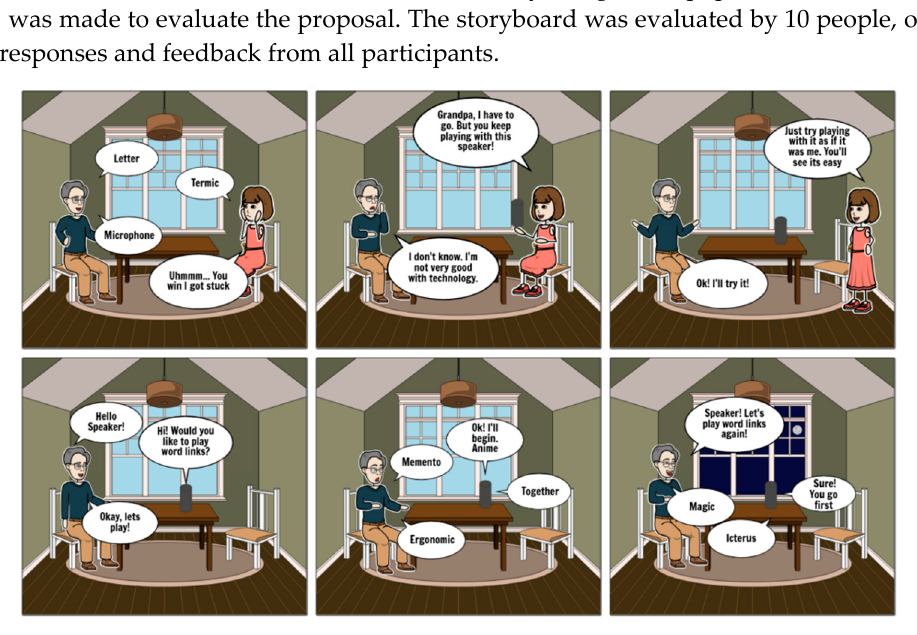
Figure 1. Initial sketch to demonstrate the proposed idea and asses its